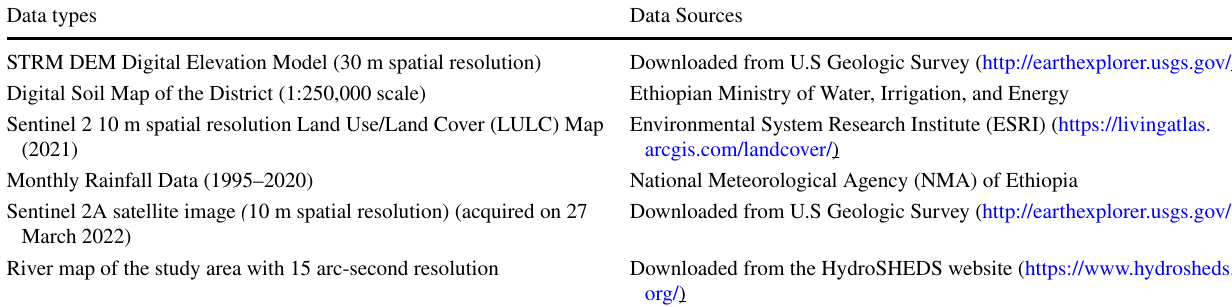
Table 1 Data types and sources used to map flood-prone